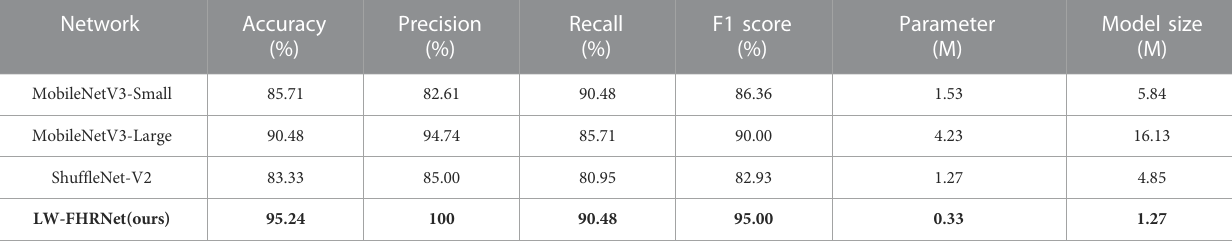
TABLE 5 Performance comparison of different lightweight models for fetal distress classi fi cation.